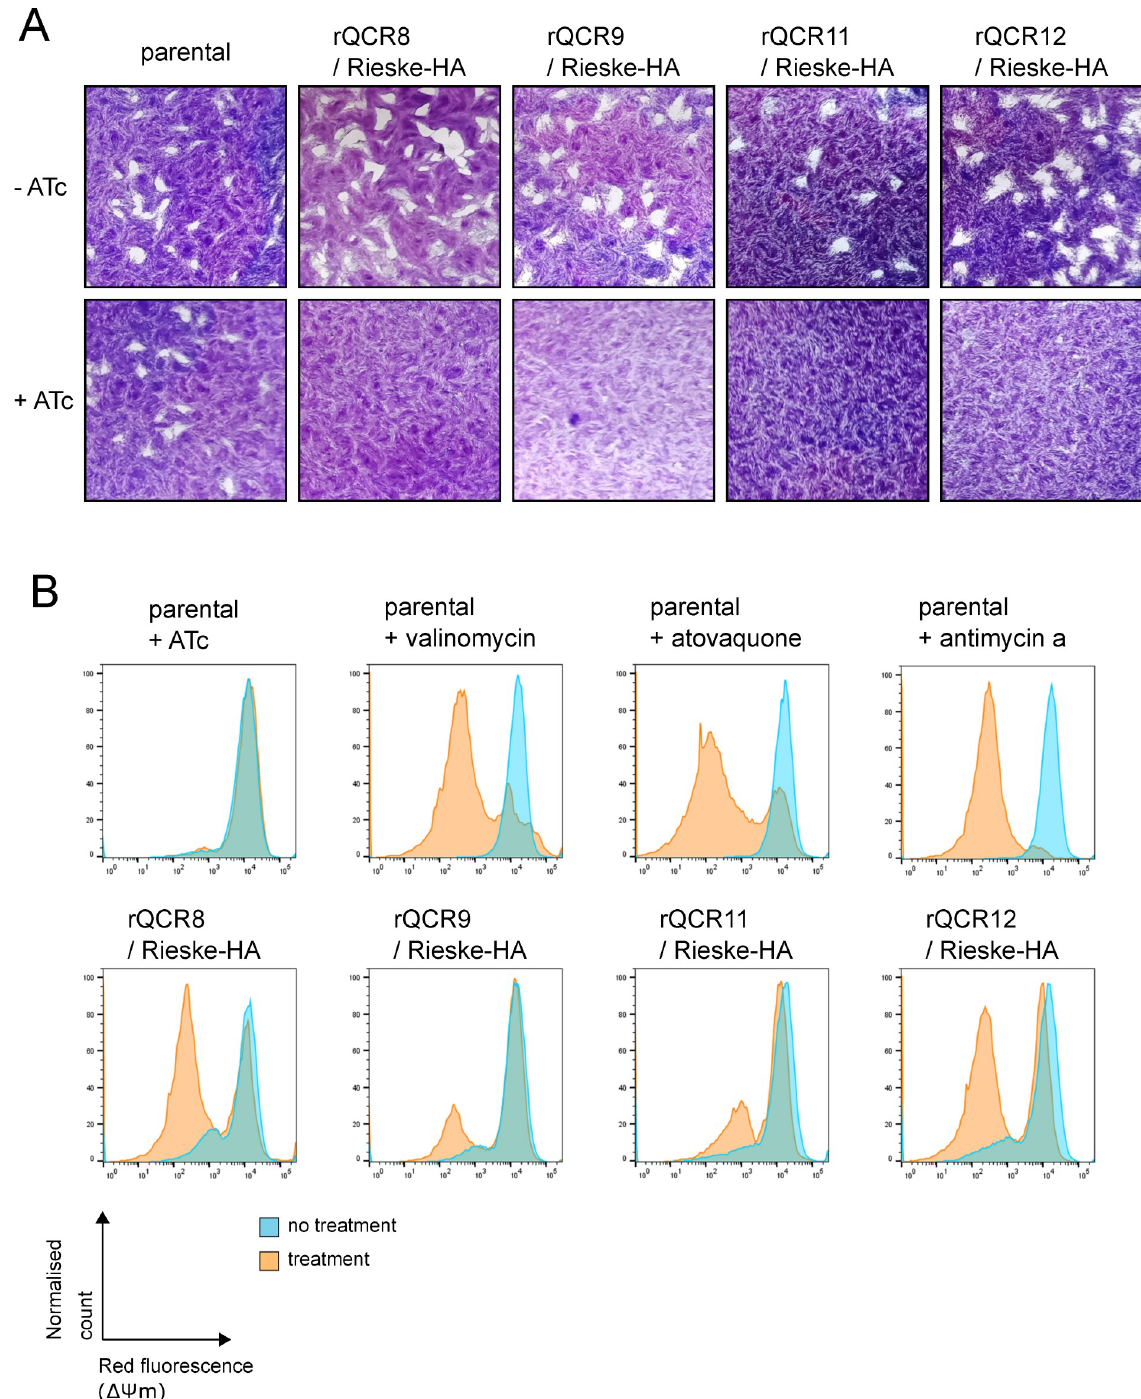
Fig 5. Loss of the new complex III subunits affects parasite growth and mitochondrial membrane potential. (A) Plaque assays of the parental line (parental) and four promoter replacement lines (rQCR8/9/11/12 / Rieske-HA). Parasites were grown for 9–10 days in the absence (-ATc) or presence of ATc (+ATc) before being fixed and stained with crystal violet. (B) Mitochondrial membrane potential detected using the JC-1 probe of parental (parental) and each of the four promoter replacement lines (rQCR8/9/11/12 / Rieske-HA) in the absence (blue) or presence (orange) of ATc, or valinomycin/atovaquone/antimycin a. Representative histograms of red fluorescence, which is dependent on mitochondrial membrane potential, recorded by flow cytometry are shown.